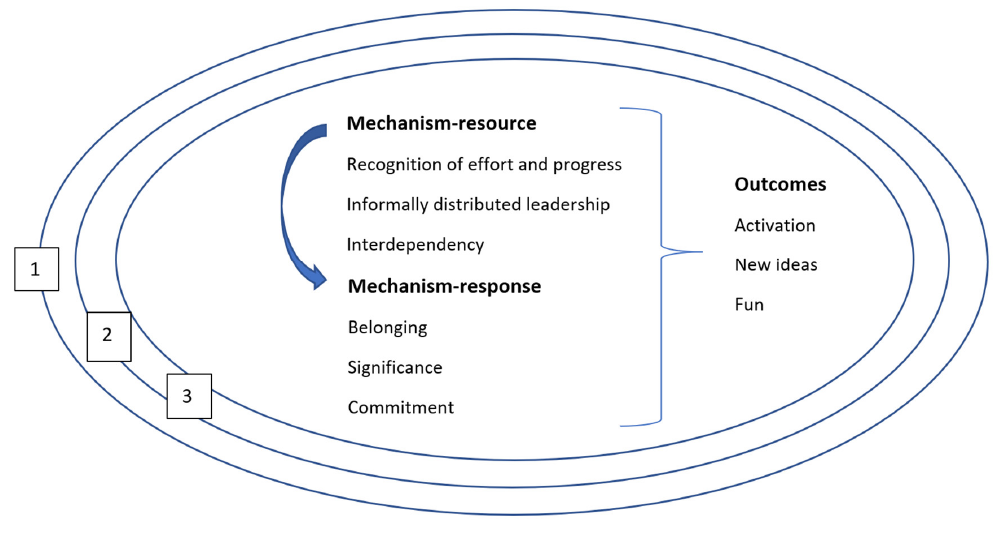
Figure 2. Refined MRPT for collaboration in developing and sustaining DFI.